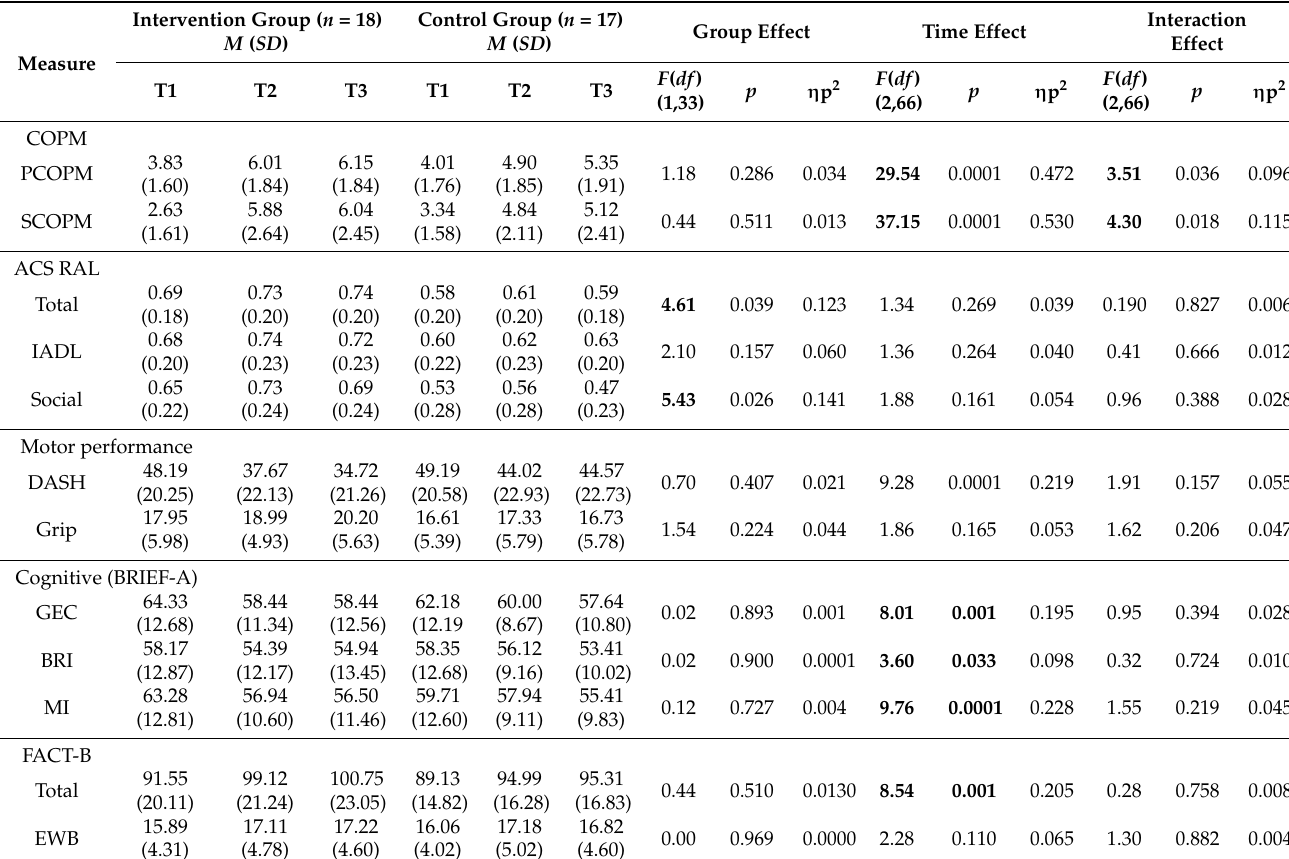
Table 2. Descriptive statistics and results of within- and between-parametric group comparisons at T1, T2, and T3.